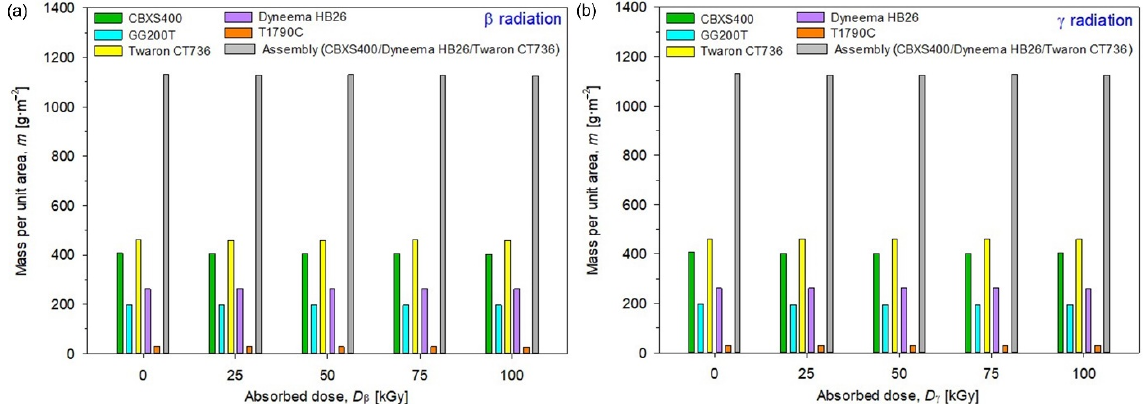
Figure 13. Mass per unit area of unmodified and irradiated textiles using ( a ) β-radiation, ( b ) γ- radiation.